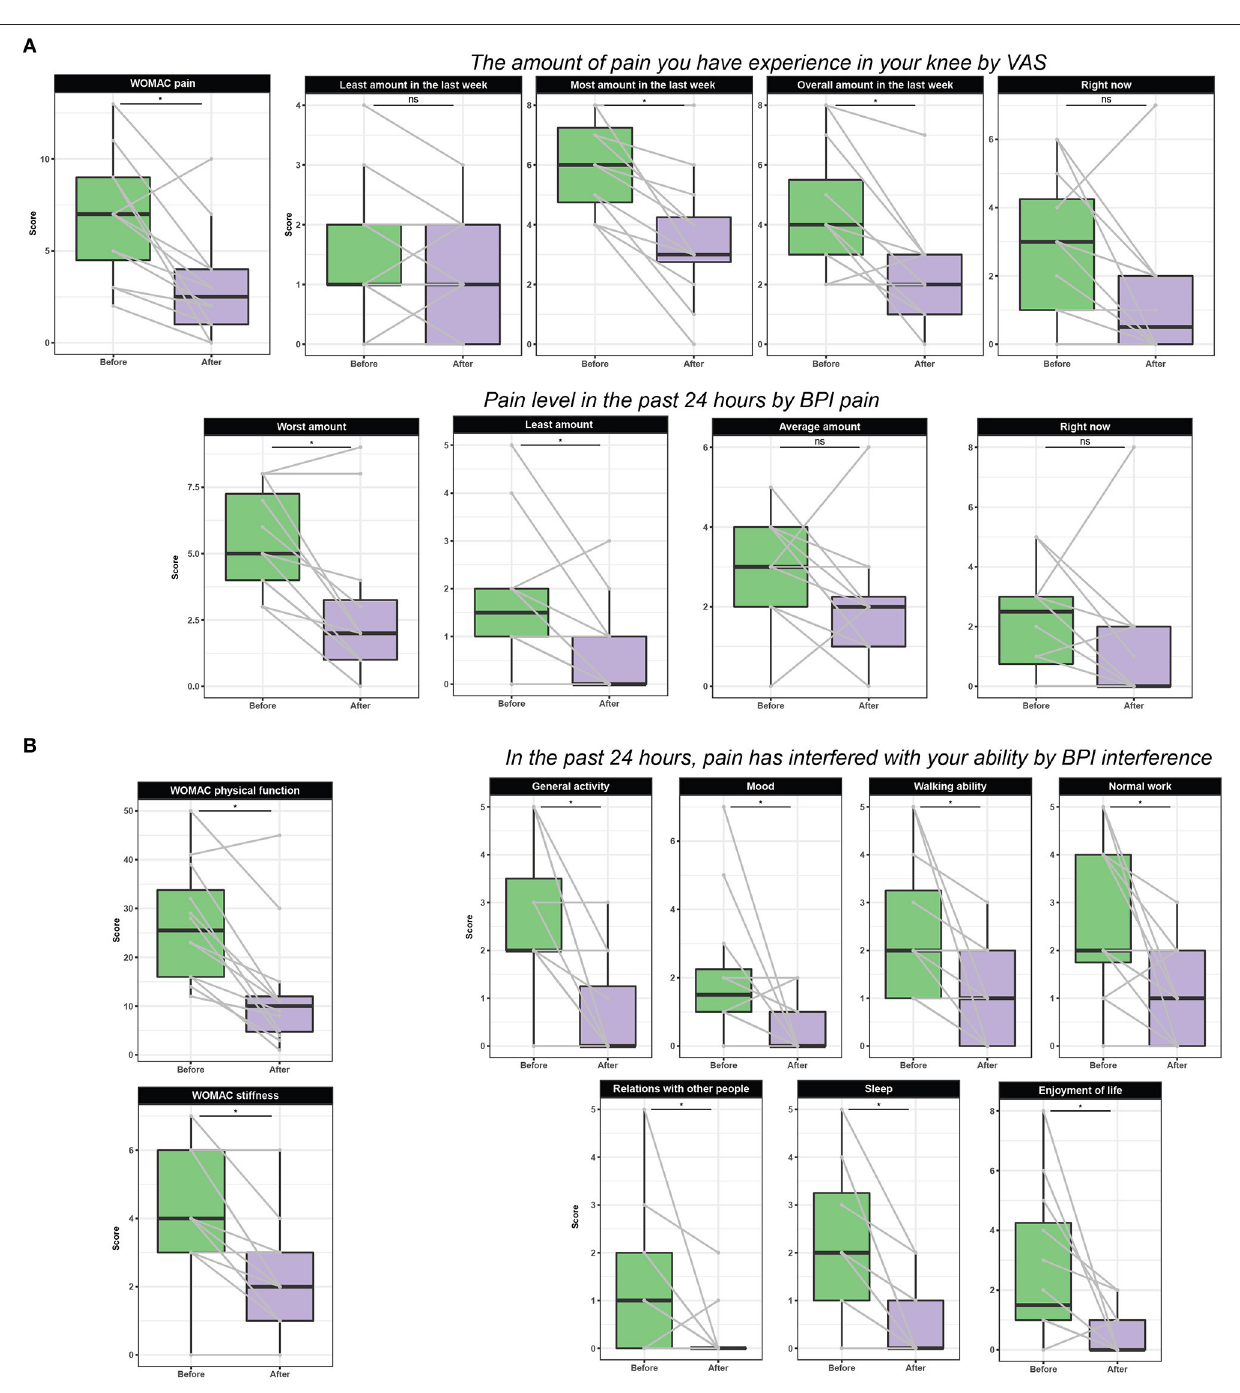
FIGURE 1 | Effect of TC on pain (A) , physical function, and stiffness parameters (B) . Data are presented as boxplots and scores from the same subject is connected with a gray line. Statistical significance of differences was determined at an alpha level adjusted for multiple comparisons (i.e., Benjamin-Hochberg adjustment). WOMAC: Pain subscale from 7 (no pain) to 35 (extreme pain); Stiffness subscale from 2 (no stiffness) to 10 (extreme stiffness); Physical function subscale from 17 (no difficulties with activity of daily living) to 85 (extreme difficulties with activity of daily living). Overall WOMAC scale from 26 (best possible score) to 130 (worst possible score) due to knee pain. VAS (visual analog scale) from 0 (no knee pain) to 10 (unbearable pain). BPI (Brief Pain Inventory) from 0 (no pain) to 10 (unbearable pain). the analyzed samples, which were further used in the including acylcarnitines, diglycerides, triglycerides, LPC, PC, sphingomyelins, ceramides, and cholesteryl esters. Among all metabolites, 295 metabolites were detected in at least half of